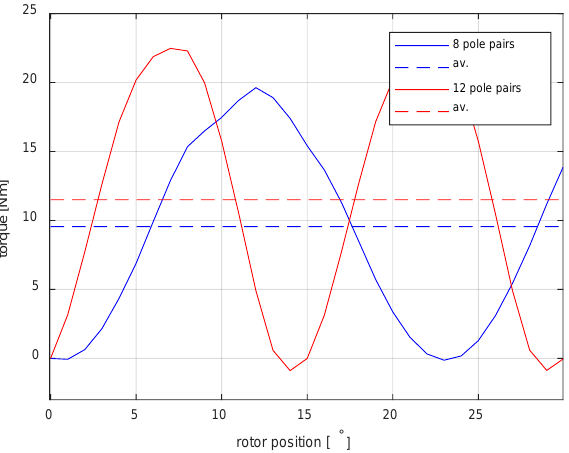
Figure 9. Electromagnetic torque and its average value for a one segment of cogging motor with eight and 12 pole pairs.